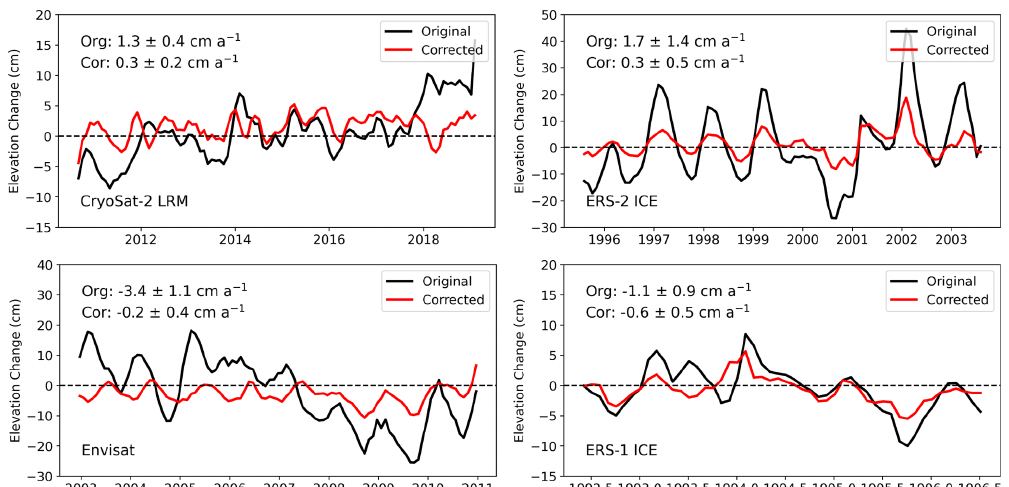
Figure 2. Original and scattering corrected area integrated time series for Lake Vostok in East Antarctica, which has been shown to have a height trend close to zero over recent decades (Richter et al., 2014). A discrepancy in uncorrected height trends is observed for the various missions due to differences in altimetry processing, orbit configuration, and the quality of the geophysical corrections. Envisat and ERS-2 (Ice) show the largest uncorrected magnitude in both trend and seasonal signal. Corrected height change records show significantly lower seasonal amplitudes and trends that are close to